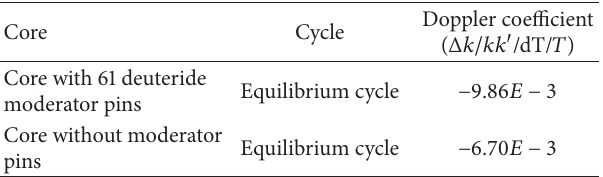
Figure 5: Assembly averaged pin power distribution in radial direction. Table 5: Comparison of Doppler coefficient between cores with and without moderator.